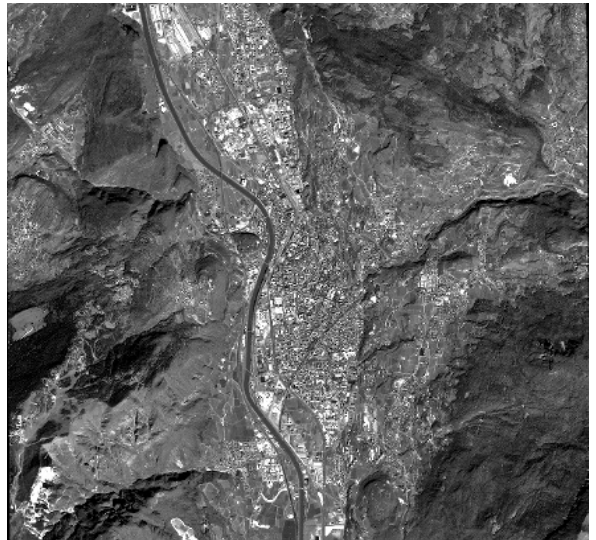
Figure 2: LiDAR reference DSM and analyzed tiles Figure 1: Pl´eiades-HR1 image The SGBM parameters choice moved within the rules expressed by the OpenCV Class Reference. Because of this, initially ndis- parities values were chosen within the array { 32 , 64 , 96 , 128 } , which contains multiples of 16 only; minimumDisp was set equal to an integer in the array {− 32 , − 16 , 0 } , thus excluding highly negative values, whereas SADWindowSize , which should range Table 1: Geographic coordinates of SRTM tile corners from 3 to 11 assuming odd values only, was chosen equal either to 1, 3, 7 or 11 from trial to version) was used. The tile corner coordinates are shown in Table 1.